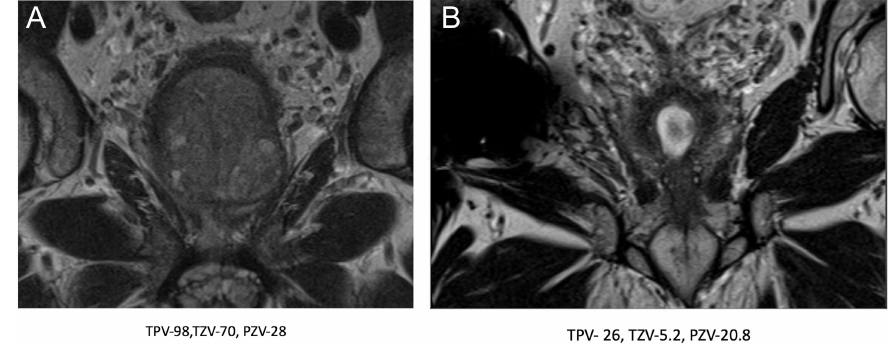
Figure 3. a,b. T2 weighted coronal MRI images before and 7 month after HoLEP procedure (volume in